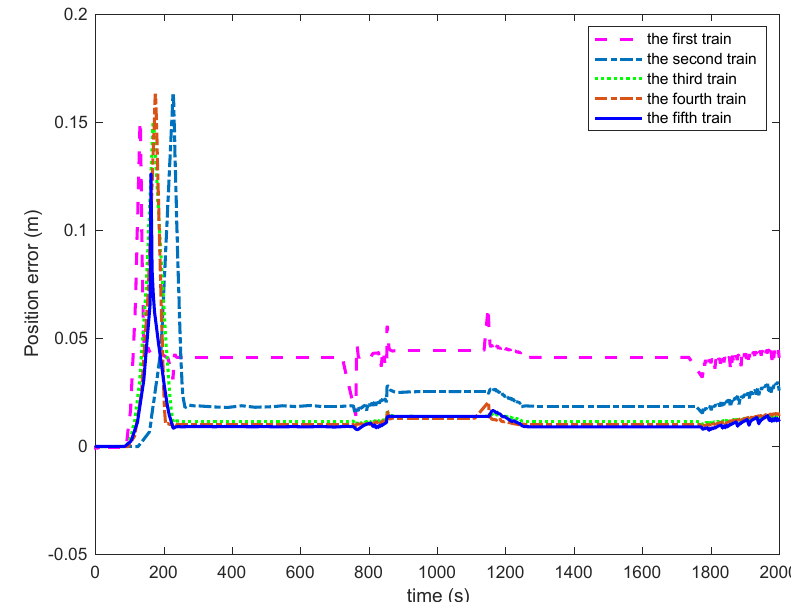
Figure 3. Position tracking error of each train.